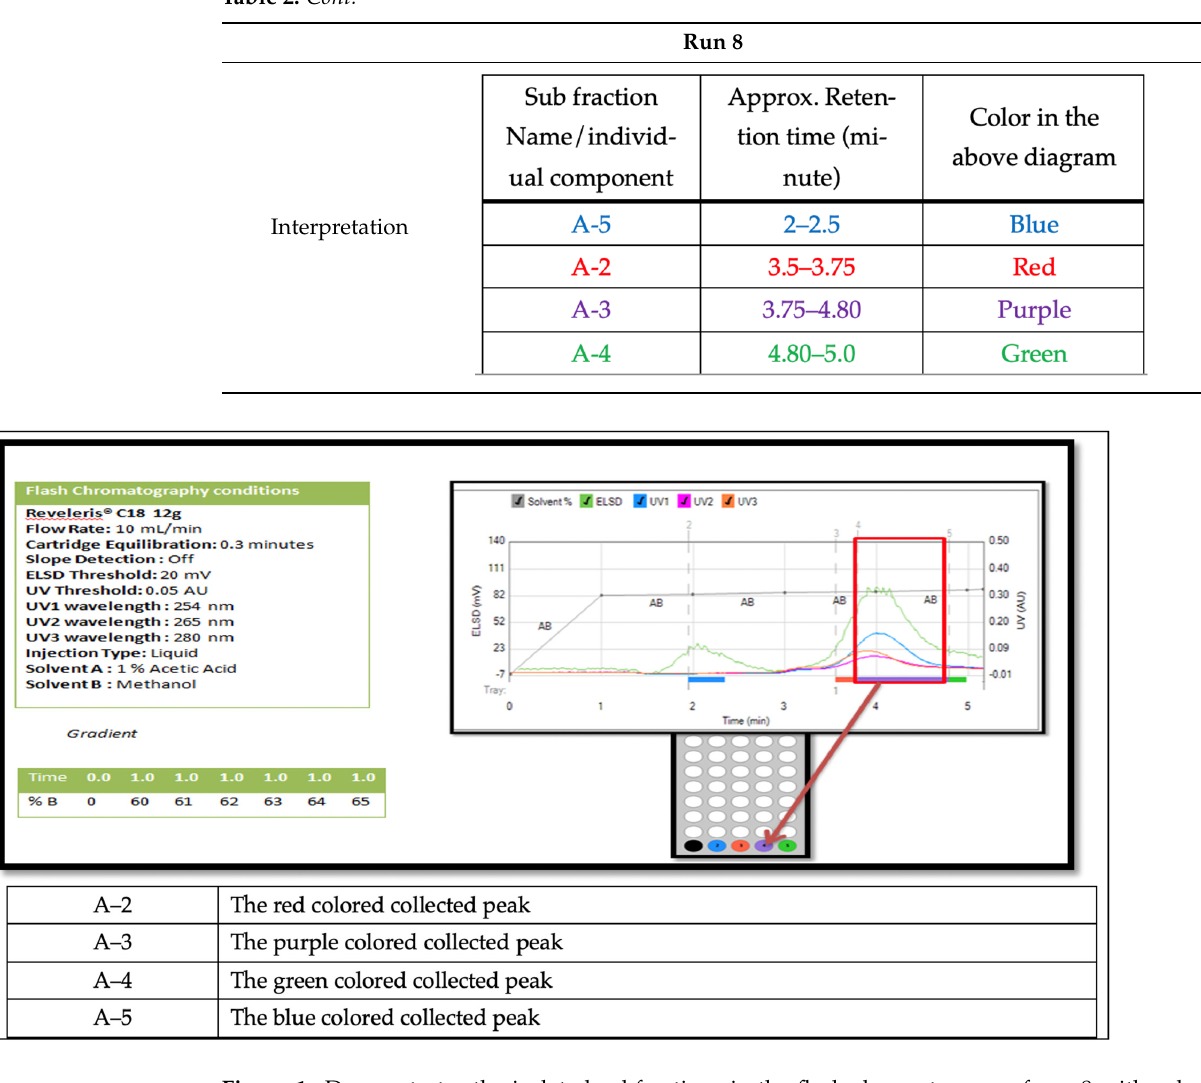
Figure 1. Demonstrates the isolated subfractions in the flash chromatogram of run 8 with color indicating the fractions separated.